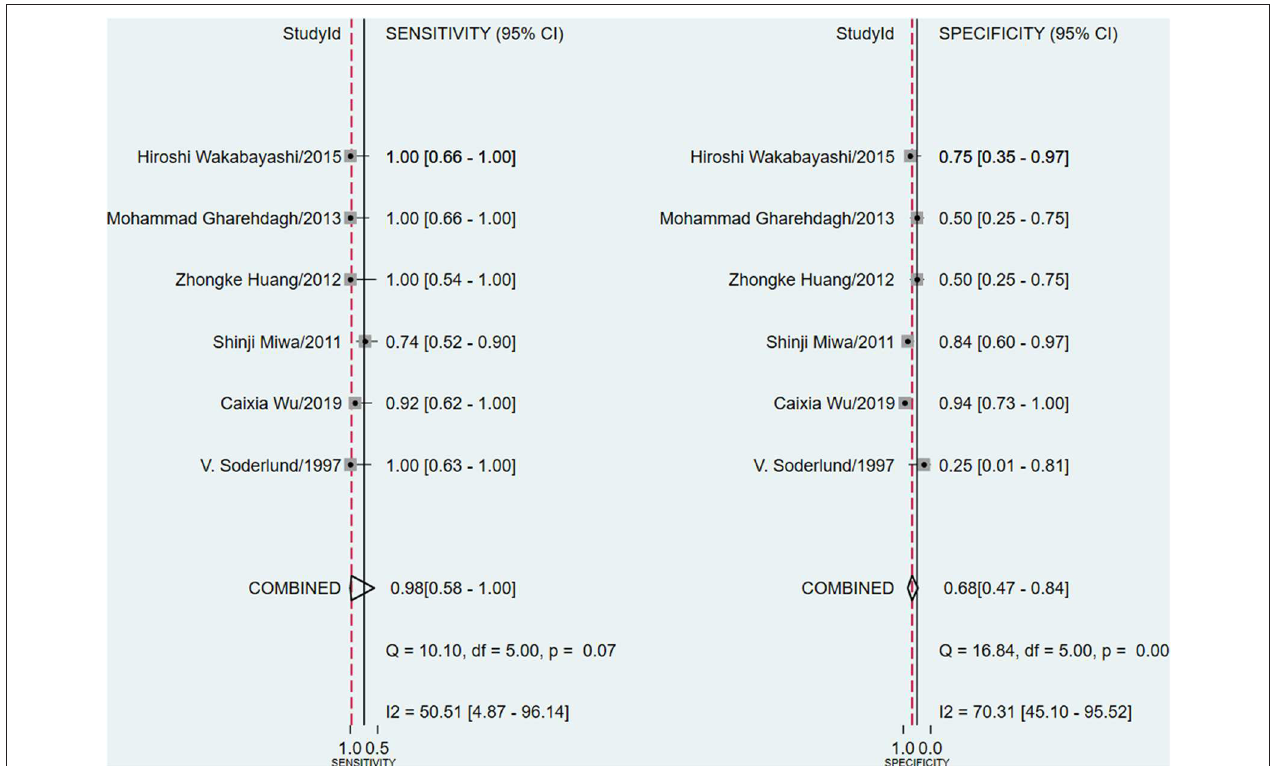
FIGURE 2 | Forest plots of the pooled sensitivity and specificity for the uptake change ratio of 99m Tc-MIBI scintigraphy in preoperatively assessing the response of osteosarcoma patients to neoadjuvant chemotherapy.